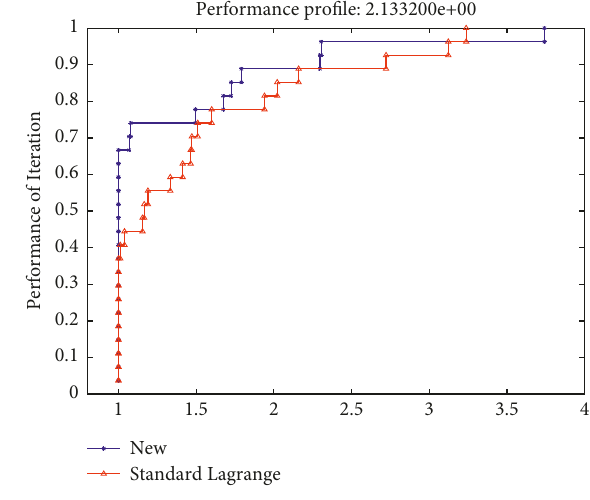
Figure 1: The performance of the given methods relative to iterations.